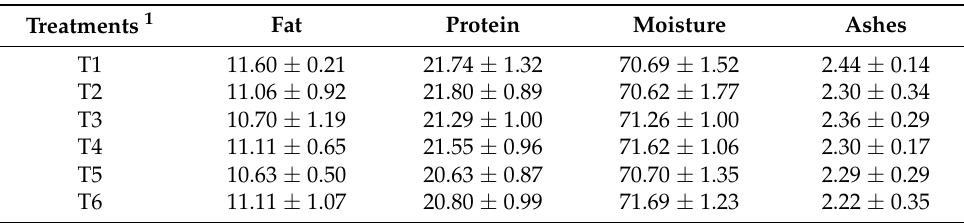
Table 1. Chemical composition (mean ± standard deviation) of beef hamburgers added to essential oils of rosemary ( Rosmarinus officinalis ) and garlic ( Allium sativum ) and oleoresins of chipotle pepper ( Capsicum annum ).